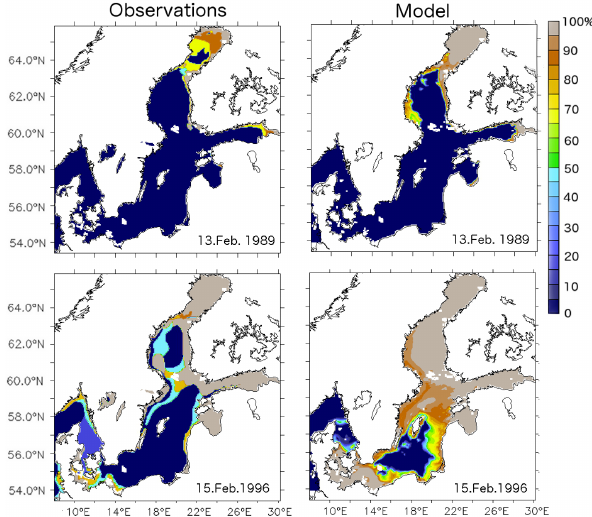
Figure 18. Snapshots of observed (left column) and simulated (right column) ice concentrations for exemplary days in mid-February, during a particularly warm (1989, upper panels) and cold winter (1996, lower panels). Units are in percent.